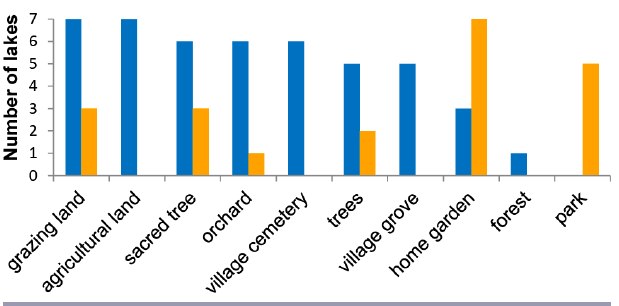
Fig. 3 . Land use in the seven lake areas for both past conditions (around 1980, blue bars) and current conditions (2015, yellow bars).